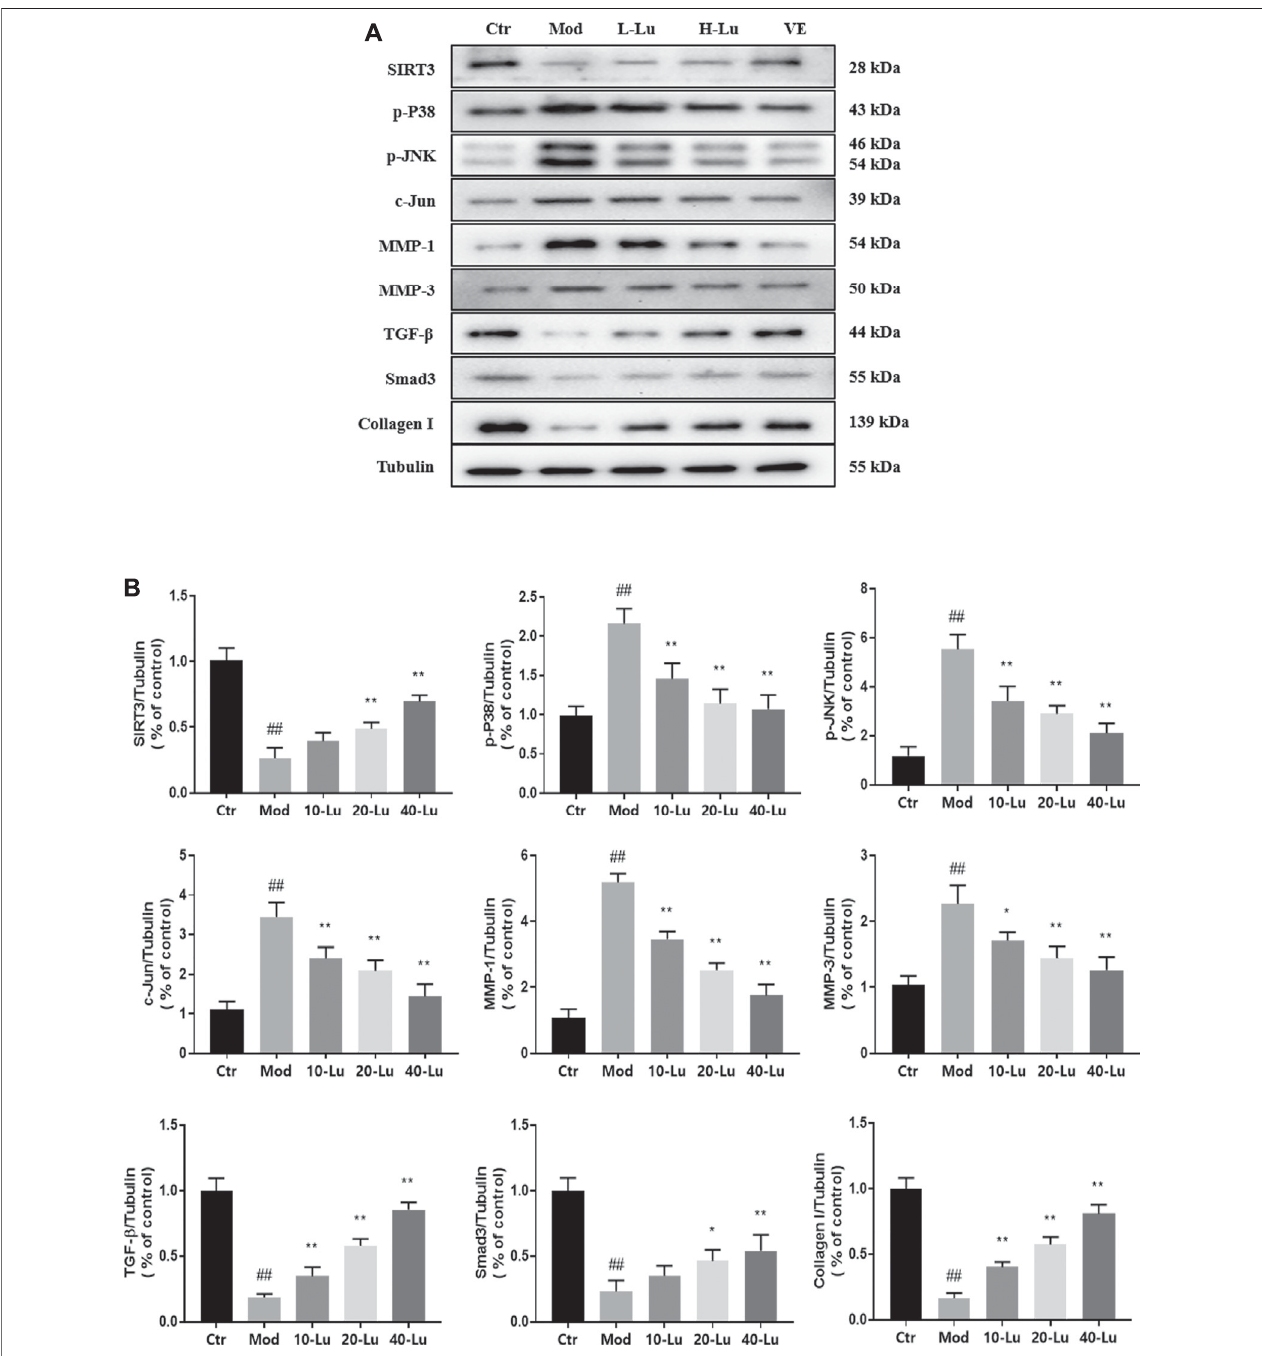
FIGURE 6 | Luteolin inhibits UVB-induced activation of MMPs and p38 MAPK in vitro . (A) Representative immunoblots of SIRT3, p-P38 MAPK, p-JNK, c-Jun, MMP-1, MMP-3, TGF- β , Smad3 and Collagen I protein expressions in cell. (B) Optical density histograms of SIRT3/Tubulin, p-P38/Tubulin, p-JNK/Tubulin, c-Jun/ Tubulin, MMP-1/Tubulin, MMP-3/Tubulin, TGF- β /Tubulin, Smad3/Tubulin and Collagen I/Tubulin. # indicates signi fi cant difference between the model group and the blank group (# p < 0.05; ## p < 0.01); * indicates signi fi cant difference between the administered group and the model group (* p < 0.05; ** p < 0.01).